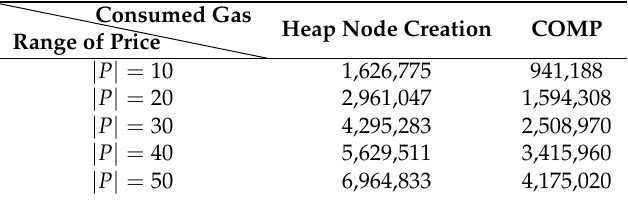
Table 3. Amount of gas consumed to perform a heap node creation and COMP